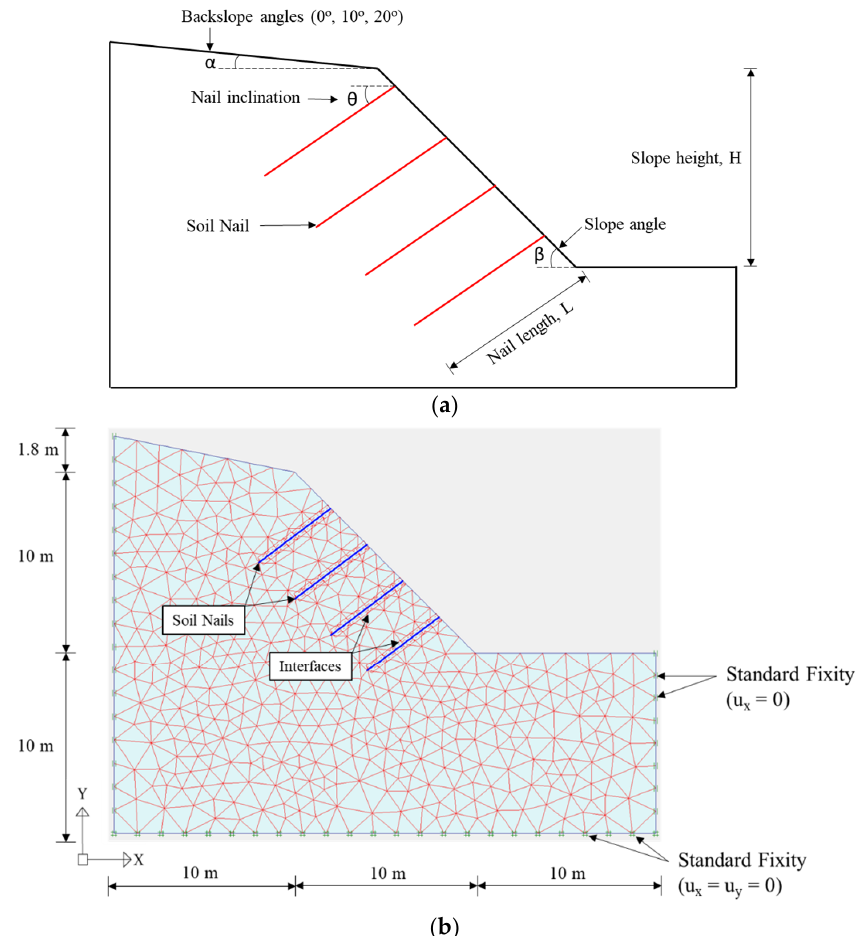
Figure 3. ( a ) Schematic diagram of the model; ( b ) PLAXIS model with boundary conditions, interfaces, and fine mesh.